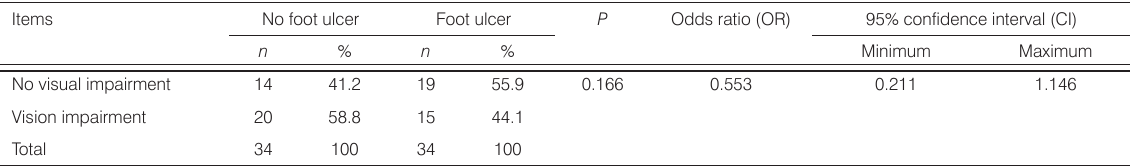
Table 1. Relationship between visual impairment and the incidence of diabetic foot ulcers in the general hospital of Dr. Moewardi Surakarta in December 2012.